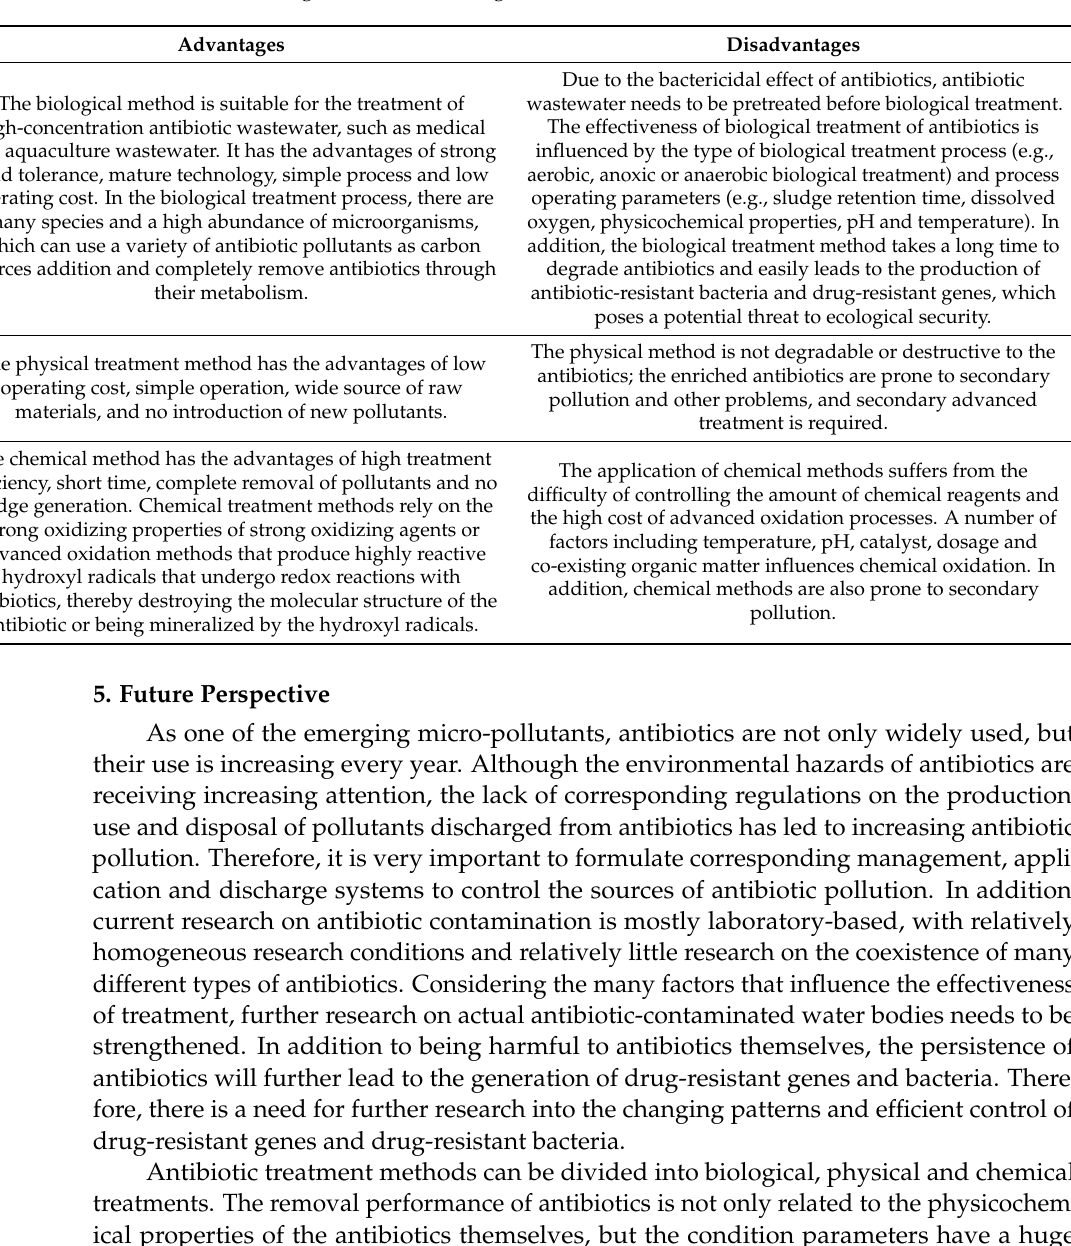
Table 7. The advantages and disadvantages of the three treatment